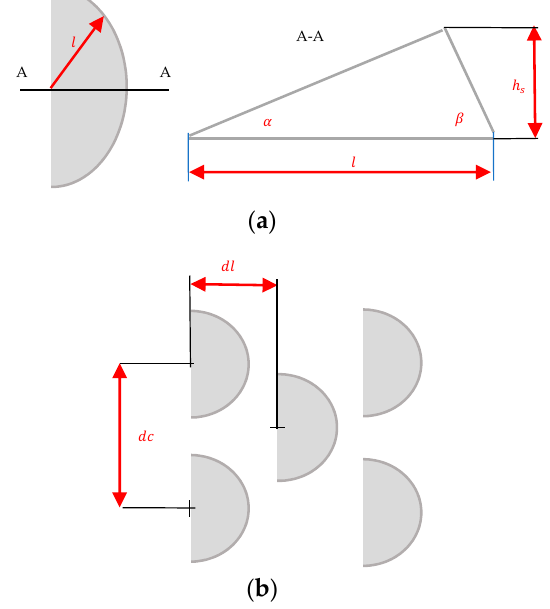
Figure 4. ( a ) Scale model geometry and ( b ) pattern